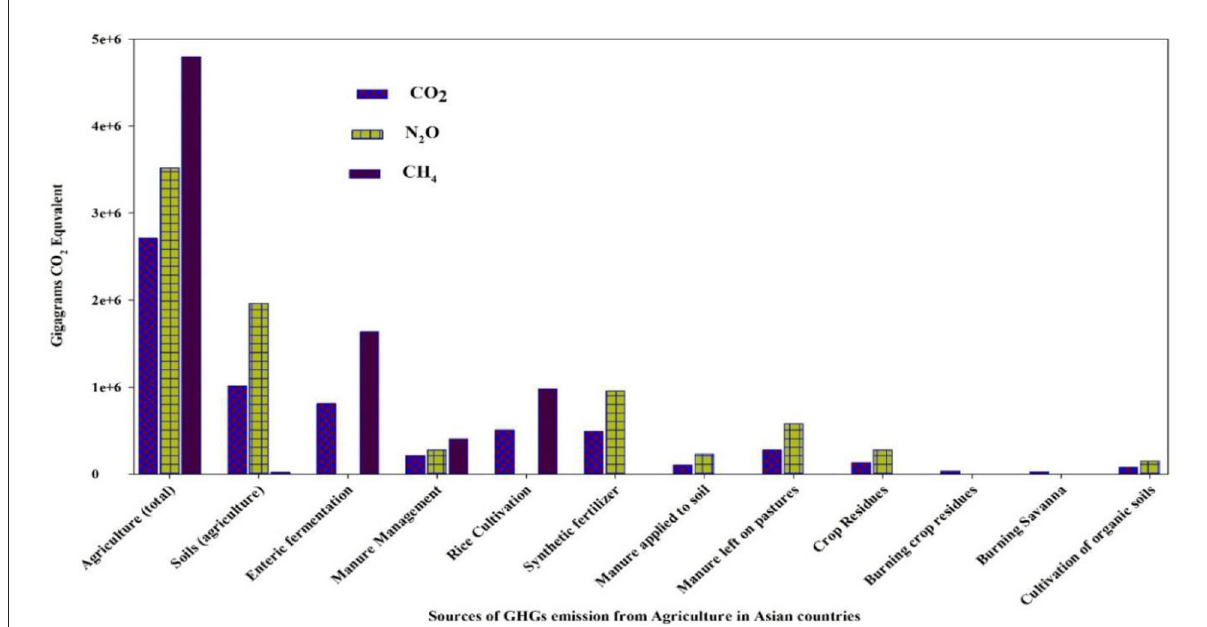
FIGURE3 Sources of greenhouse gasses (GHGs) emission from different Asian countries with respect to agricultural components (Source: CAIT climate data explorer via . Climate Watch (https://www.climatewatchdata.org/data-explorer/historical-emissions).